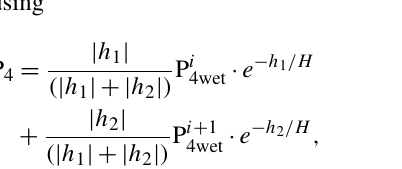
Table 1. Monthly statistics of new approach and